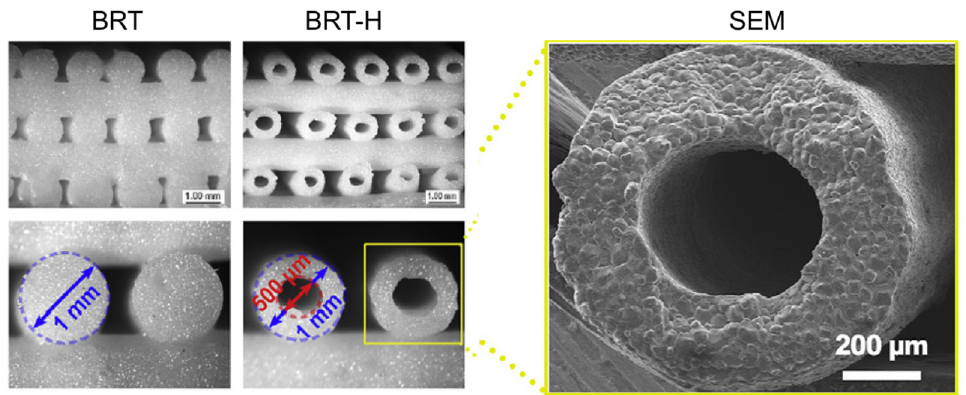
Figure 4. The structure of the BRT-H scaffolds with about 500 µ m inner channels. Reprinted (adapted) with permission from [38]. © 2017 Published by Elsevier Ltd.